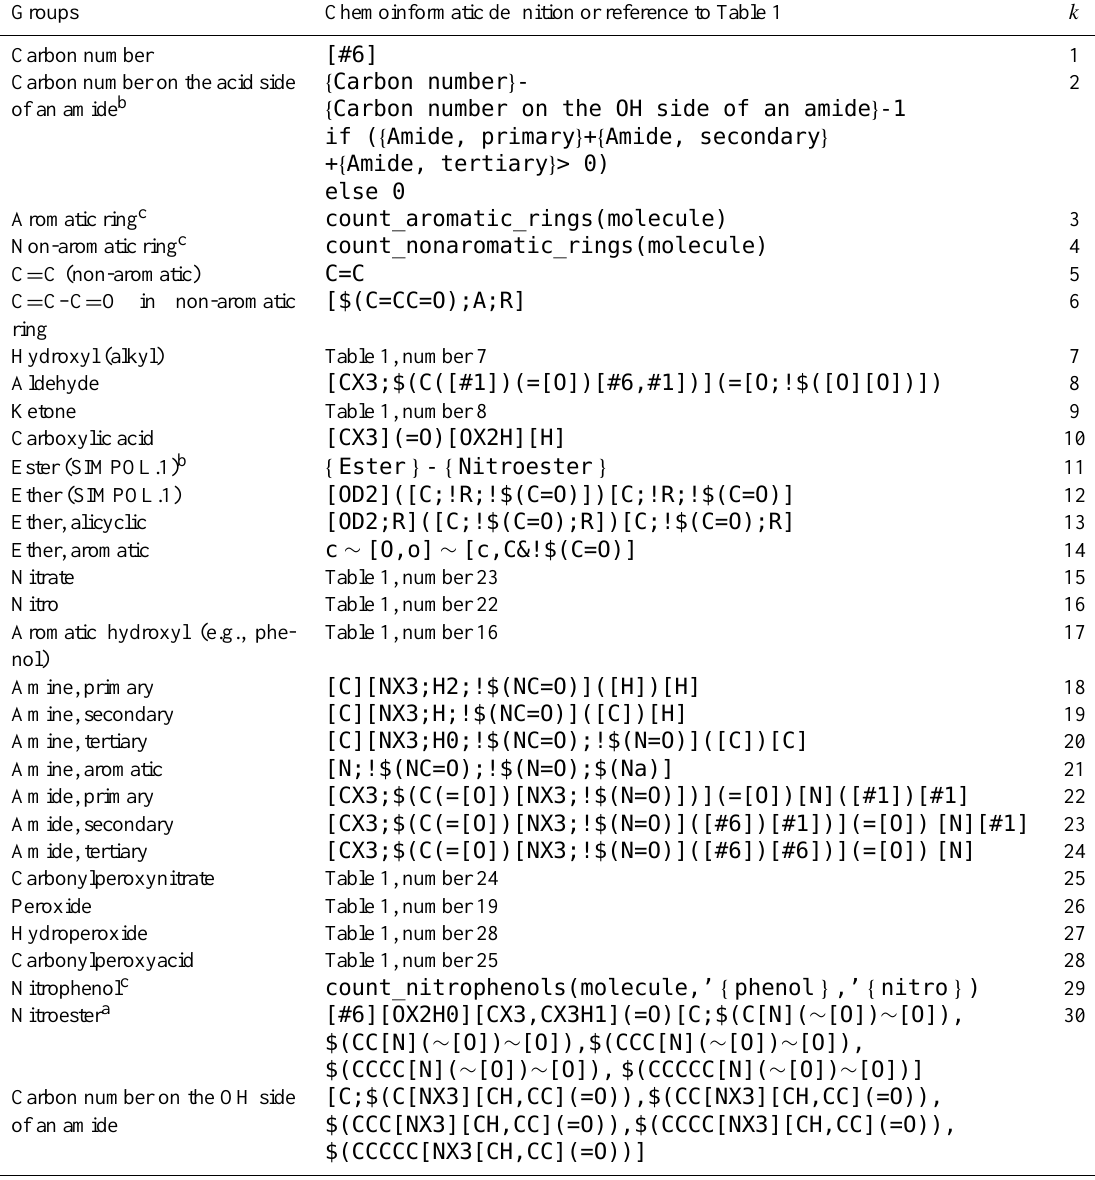
Table 2. Chemical substructures required by SIMPOL.1 model (Pankow and Asher, 2008). The column denoted by k corresponds to the group number of Pankow and Asher (2008), Table 5. For the calculation of the ester (SIMPOL.1), the generic ester specified in Table 1 (substructure 13) is specified. The group named “Carbon number on the OH side of an amide” is used in the calculation of the “Carbon number on the acid side of an amide” but is not present in the SIMPOL.1 groups indicated by Pankow and Asher